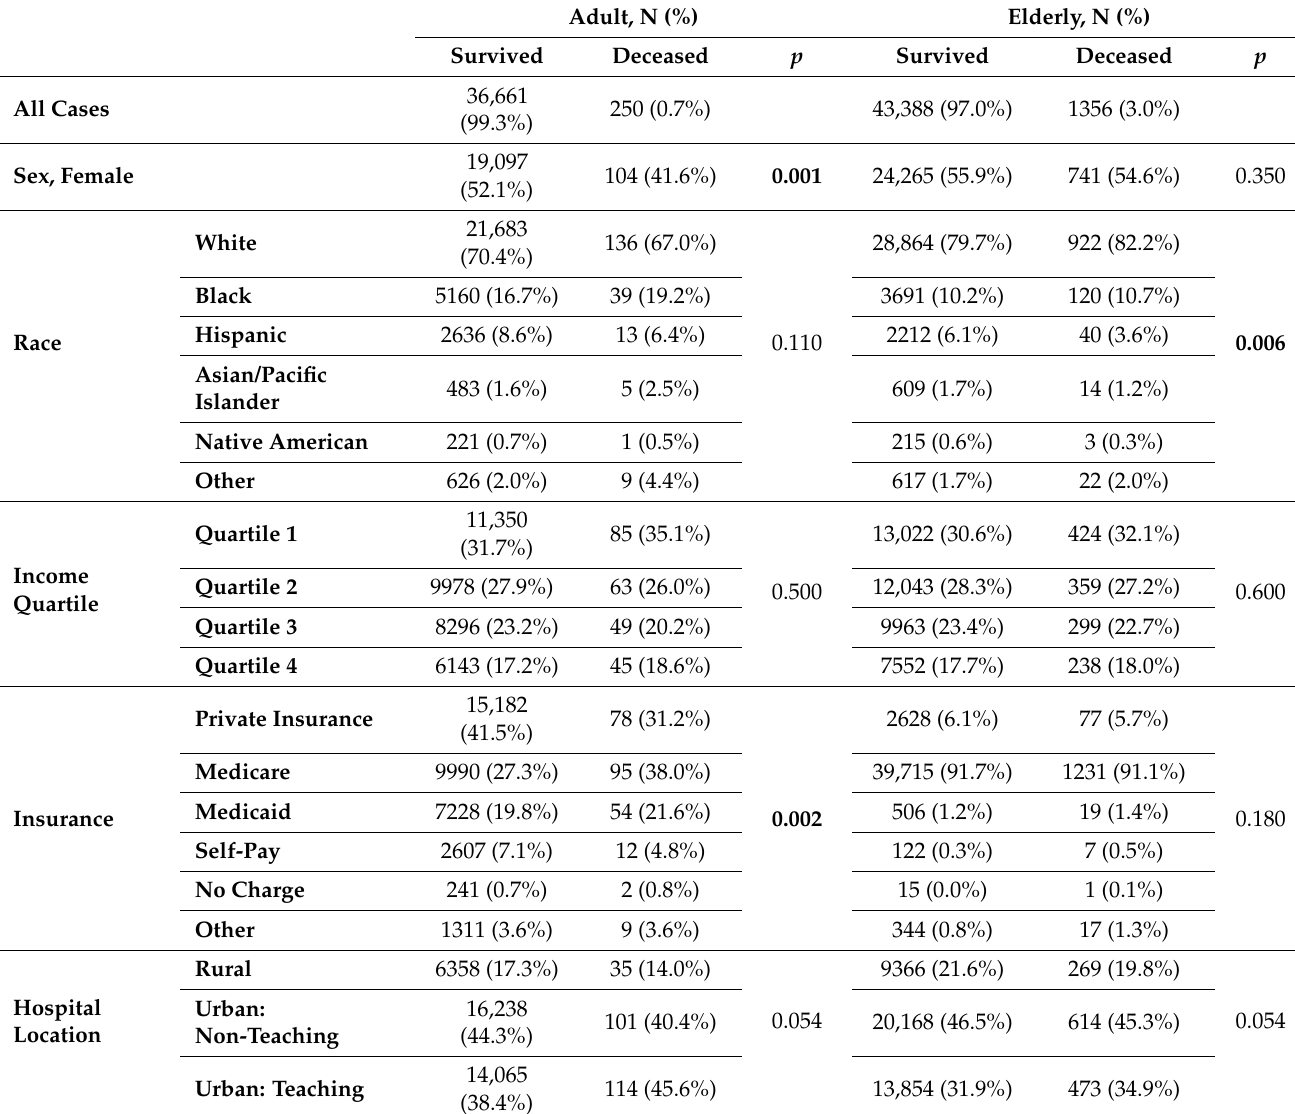
Table 3. Characteristics of emergency-admitted patients with the primary diagnosis of paralytic ileus (NIS 2005–2014). Data are classified according to outcome